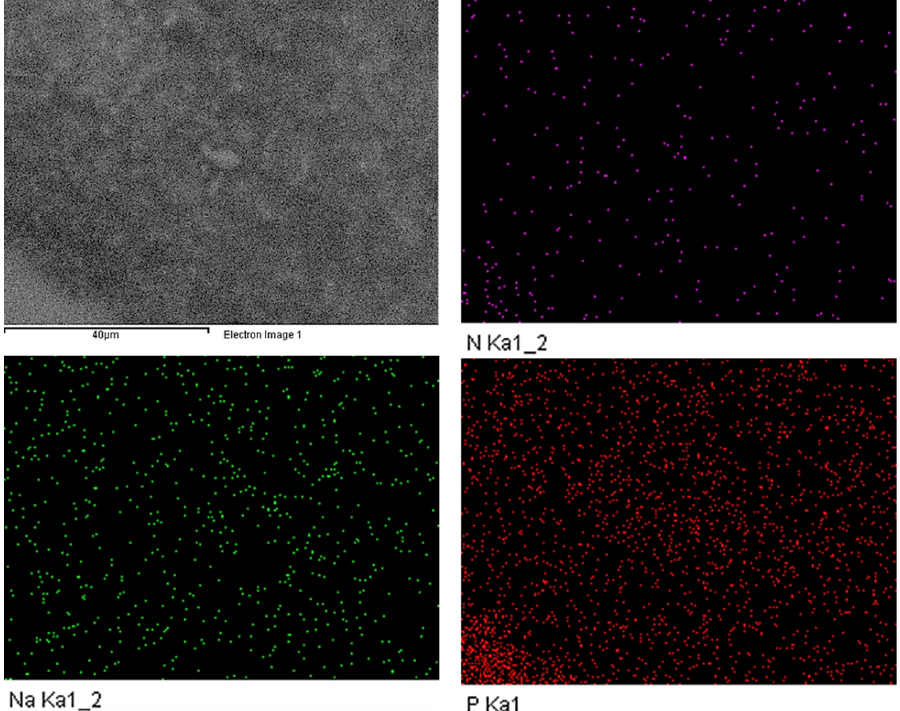
Figure 4. FE-SEM image of EMIMP/CNFc 96:4 gel and its EDS mapping on N, Na and P elements.